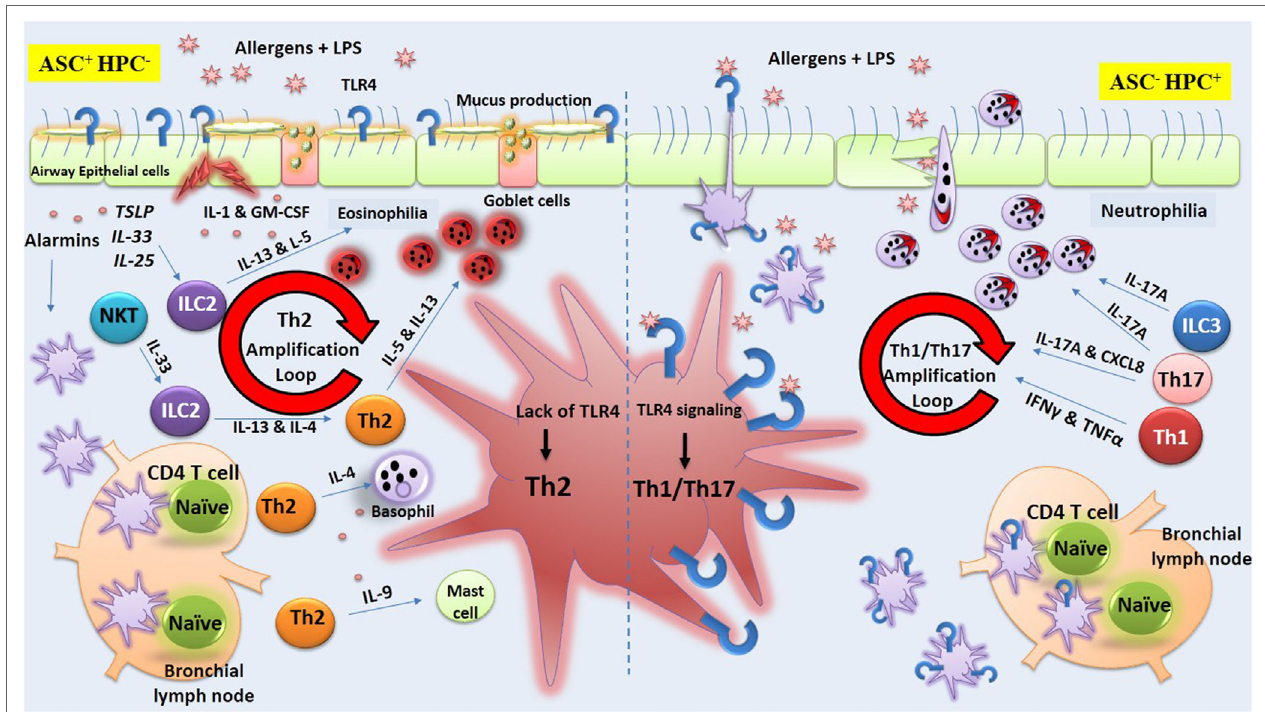
FiGuRe 3 | Toll-like receptor-4 (TLR4) signaling on airway structural cells (ASC) versus hematopoietic cells (HPCs). The figure illustrates lipopolysaccharide (LPS)-mediated TLR4 signaling exclusively on ASCs or HPC during allergen exposure that results, respectively, in orientation of immune response toward Th2 or Th1/Th17. The figure is based on studies obtained in chimeric mice showing that stimulation of TLR4 on ASCs supports Th2 immune responses while stimulation of this receptor on HPCs induces Th1/Th17 immunity. On the left side of the figure, it is shown that the lack of expression of TLR4 on HPC but not on airway structural epithelial cell (ECs) (ASC + HPC − ) results in strong Th2 response along with airway eosinophilia. In fact, TLR4 stimulation of ECs (ASC) by LPS or environmental allergens triggers the production of cytokines including alarmins (IL-33, TSLP, and IL-25) that support the development of Th2 responses via lung dendritic cells (DCs) or via other local lymphoid cells (LLCs). The production of type 2 cytokines orchestrates the activation and recruitment of eosinophils, basophils, and mast cells. In contrast, on the right side of the figure, it is shown that the lack of TLR4 expression on ASCs but not on HPCs (ASC − HPC + ) trigger the production of cytokines that support the development of Th1/Th17 immunity and airway neutrophilia via lung DCs or via other